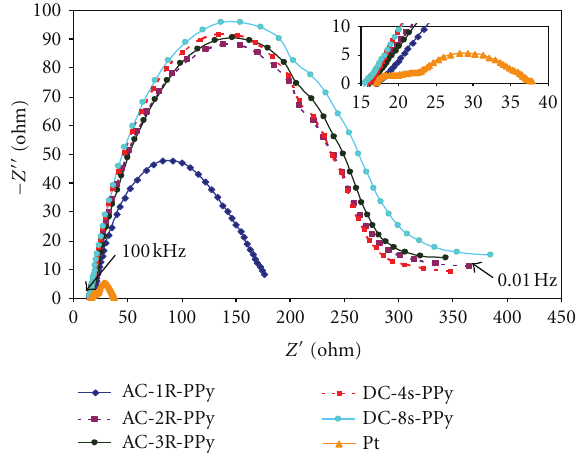
Figure 6: Nyquist plots of Pt and PPy